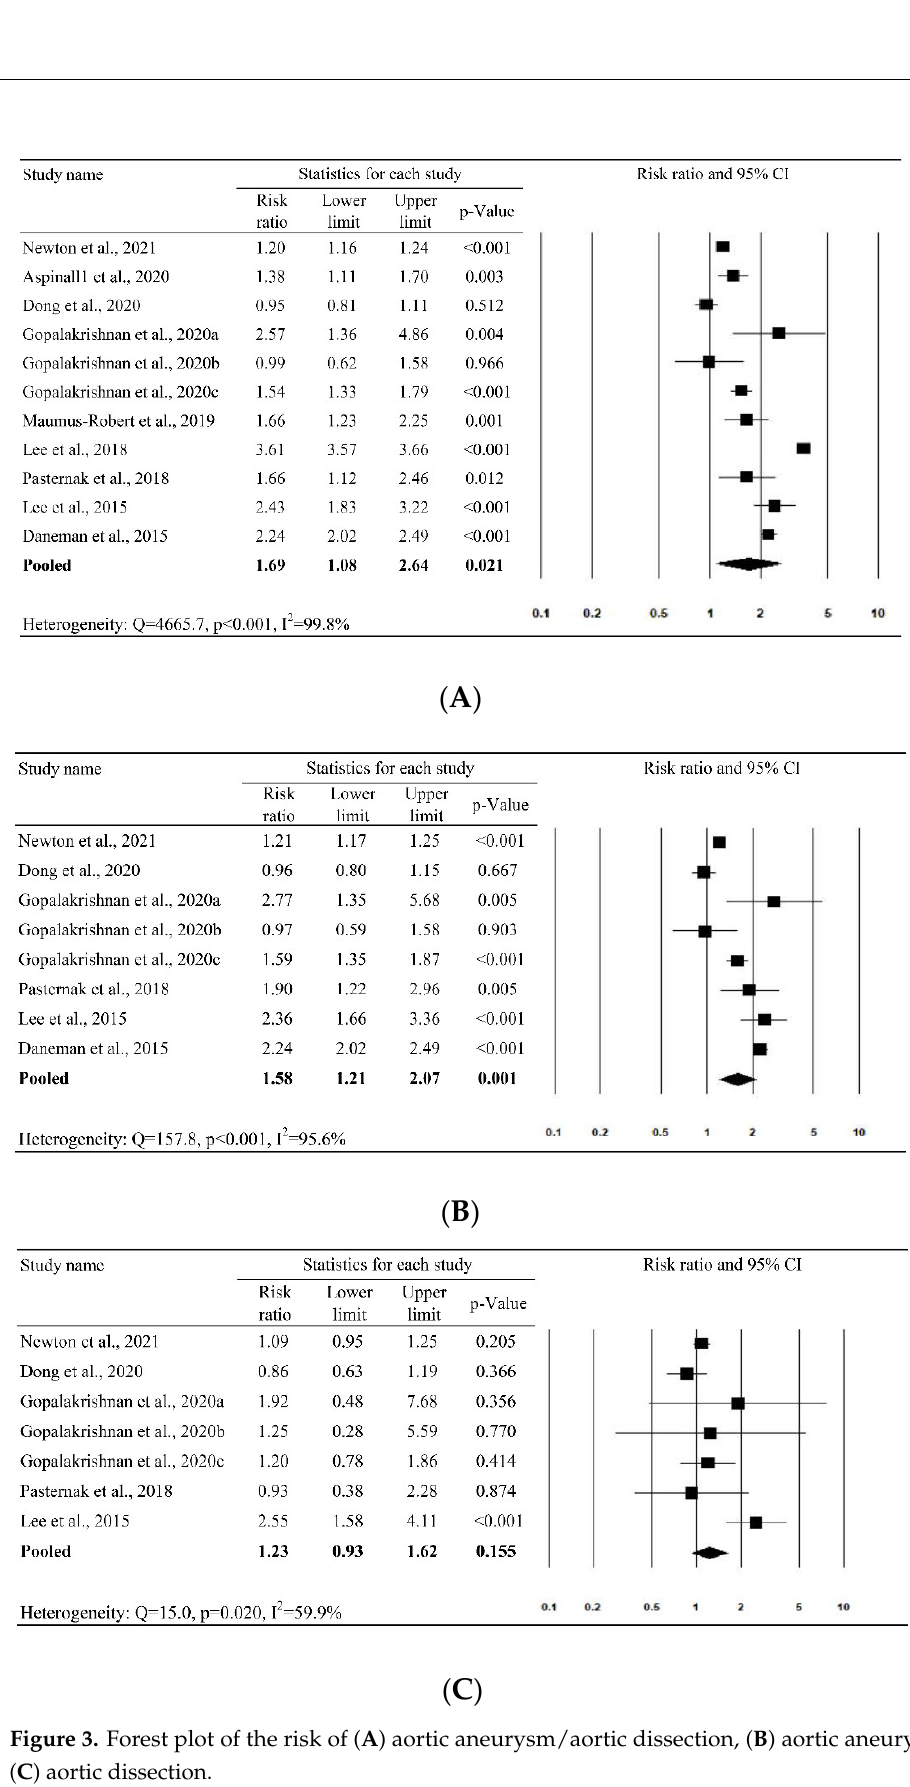
Figure 3. Forest plot of the risk of ( A ) aortic aneurysm/aortic dissection, ( B ) aortic aneurysm and ( C ) aortic dissection.